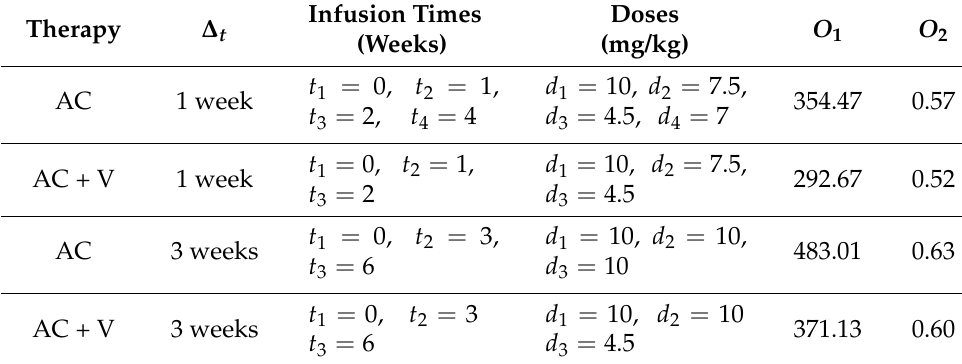
Table 4. Numerical results for the optimization problem OP1. Anti-CTLA4 has been administered as mono-therapy (AC) and in combination with dendritic cell vaccine (AC + V). Both the immunothera- pies have been tested by taking into account the general constraints defined in Section 2.5 and an additional constraint concerning the minimum time interval between two infusions ( ∆ t ) fixed as 1 or 3 weeks. Column three and four list the infusion times and doses predicted by the model as the optimal schedules. The values O 1 and O 2 represent the two components of the optimization function, namely O 1 =